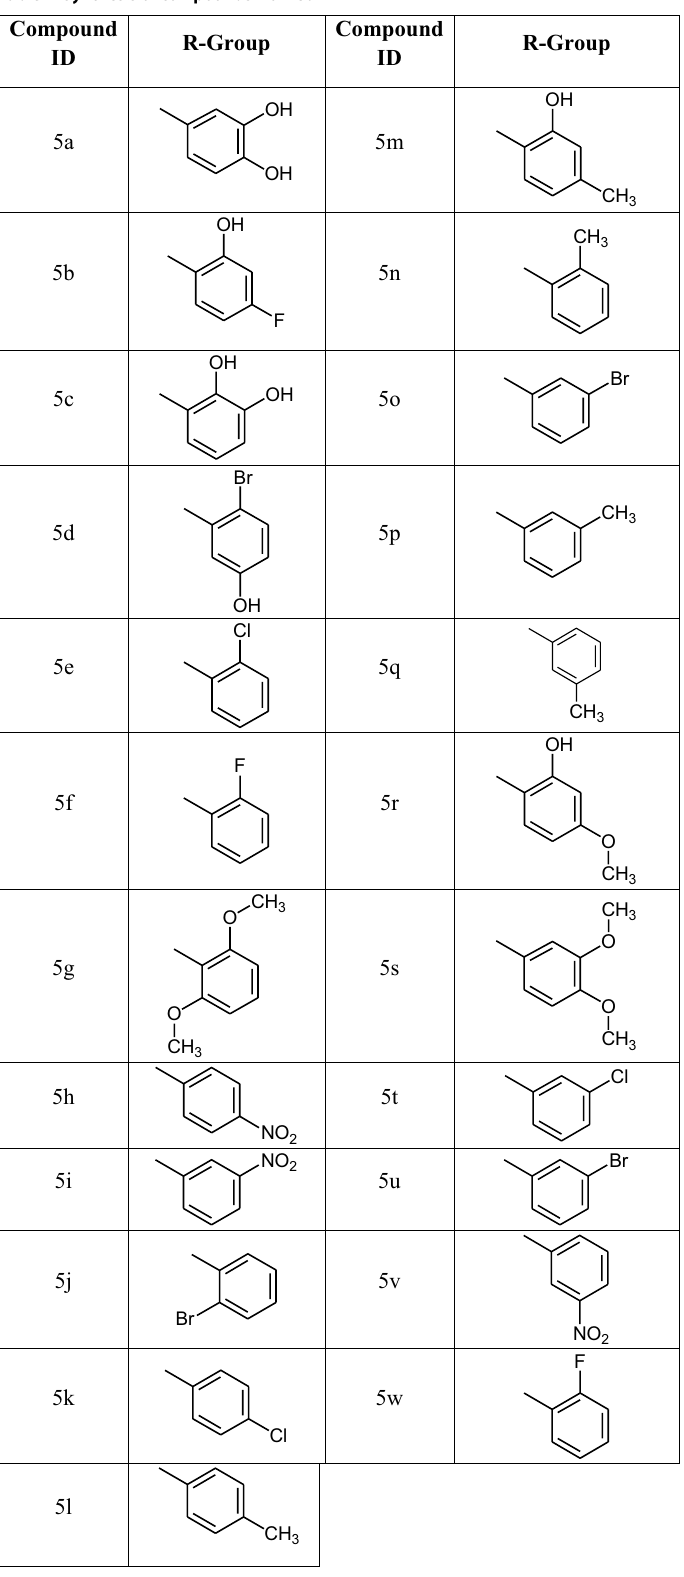
Table 1 Synthesis of compounds from 5a–w